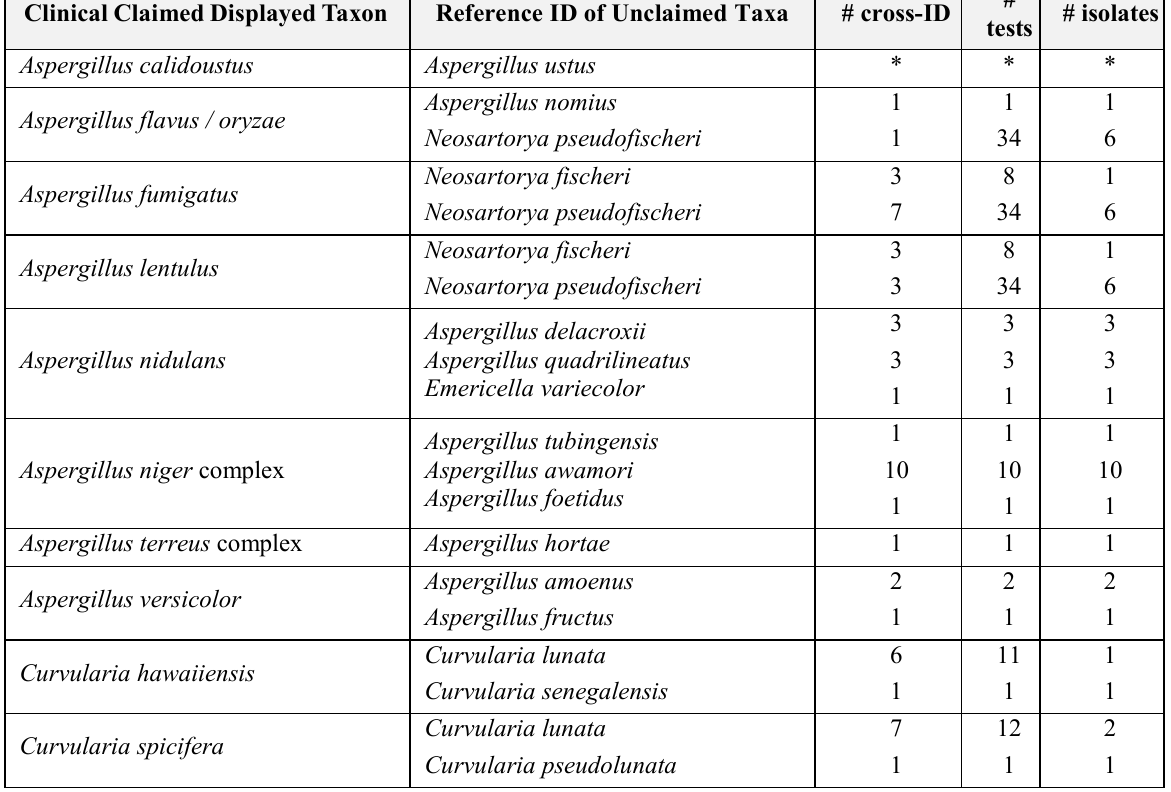
TABLE 9: Cross-identification of VITEK MS claimed displayed taxa and Unclaimed Taxa Clinical Claimed Displayed